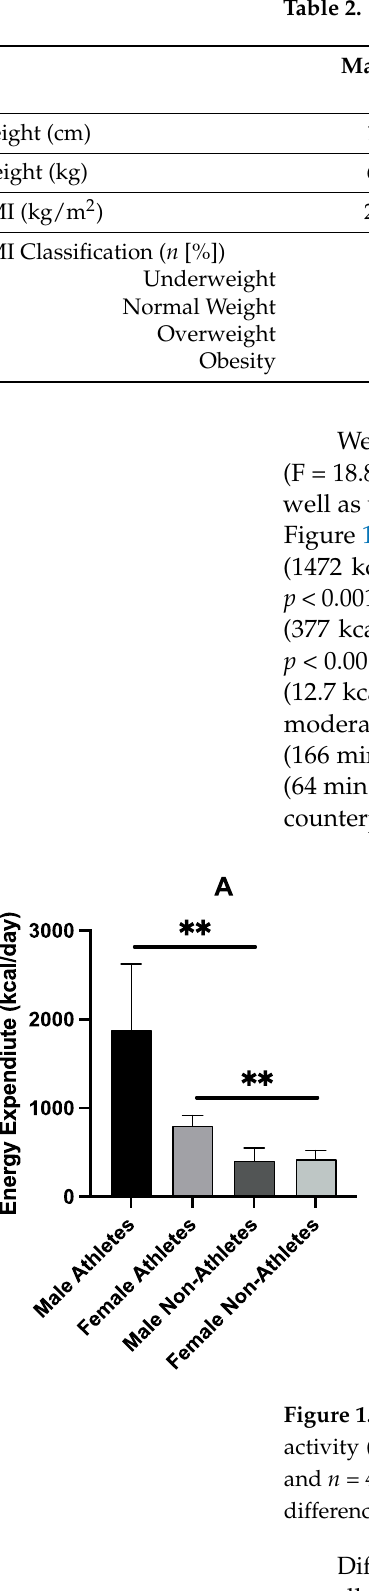
Table 2. Physical characteristics of male and female athletes and nonathletes.